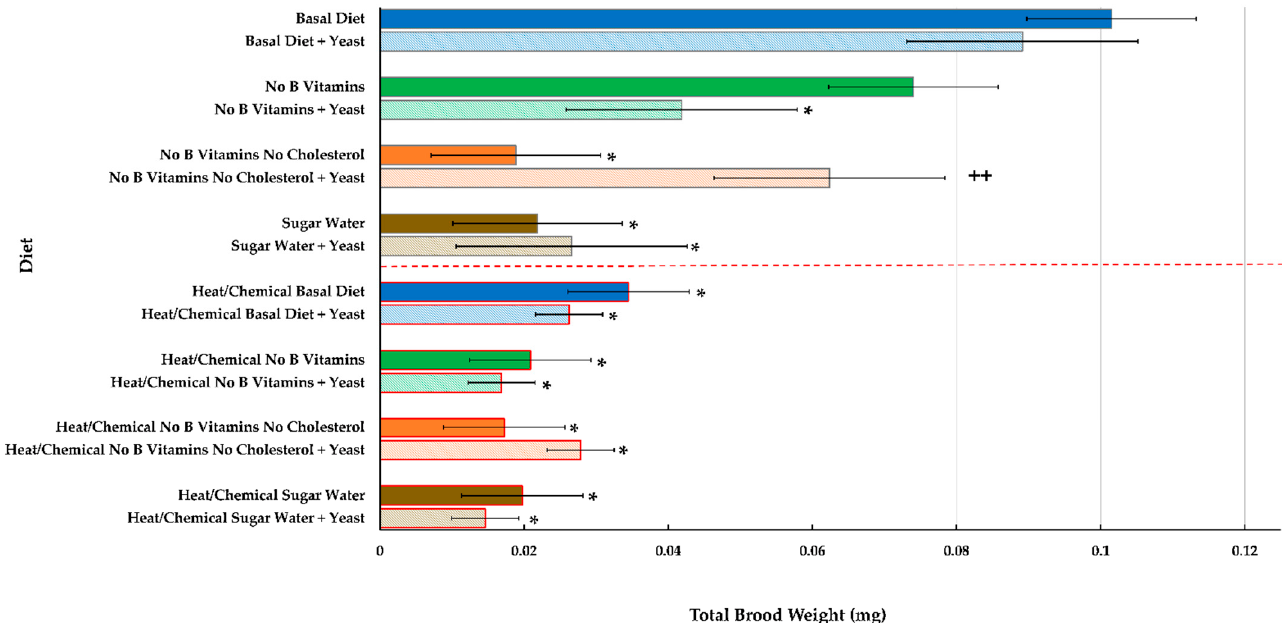
Figure 3. Total average ( n = 8) brood weights at the end of 12 weeks for groups of workers and larvae of the ant C. vicinus either not exposed or exposed to a heat/chemical defaunation (red dotted line and red border bars) and fed eight different diets where various components were deleted and/or augmented with exposure to live yeast ( S. polymorphus ). Comparisons were made for all diets to the basal (all component) diet non-defaunated treatment (top blue bar), as well as with regard to yeast exposure or no yeast exposure. An asterisk (*) indicates p < 0.05 compared to the basal diet; double plus (++) indicates p < 0.05 compared to the same diet with or without yeast.